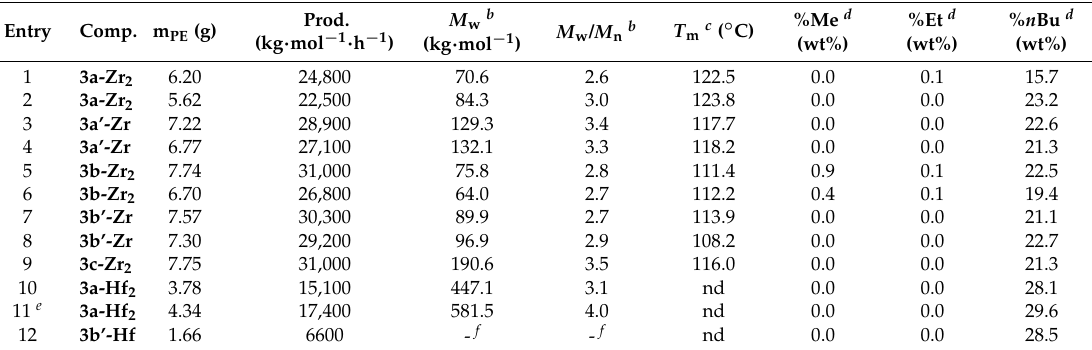
Table 2. Ethylene/1-hexene copolymerization a